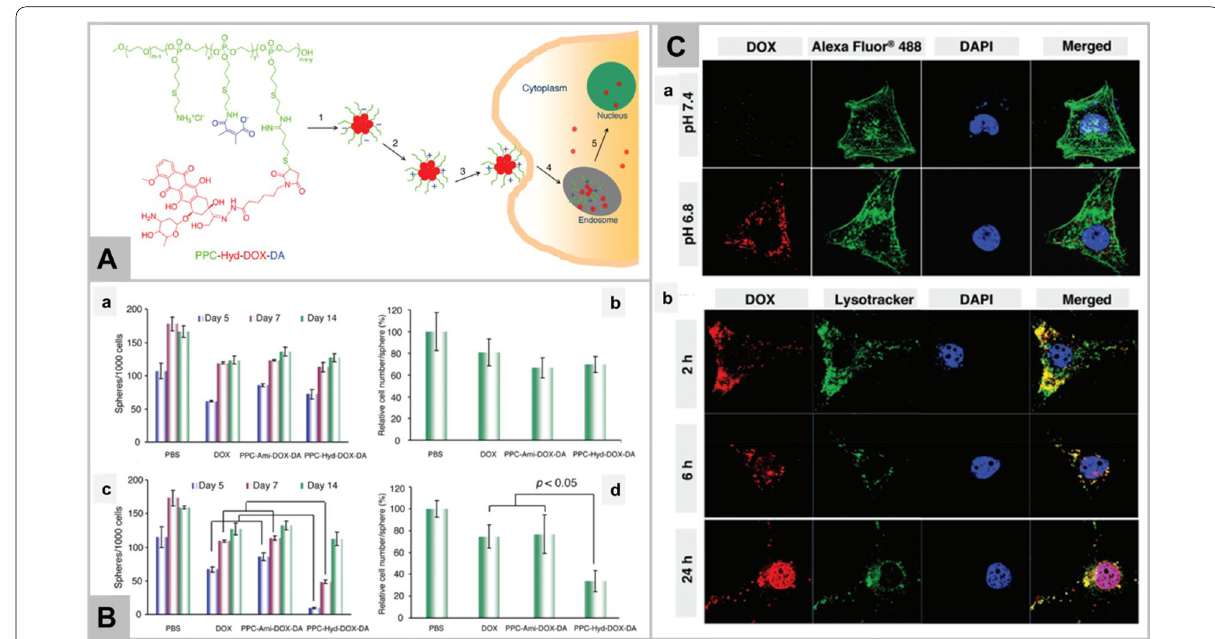
Fig. 8 Chemical Structure of the Dual pH-Responsive Polymer. Doxorubicin (DOX) Conjugate (PPC-Hyd-DOX-DA) and Schematic Illustration of Its pH Triggered Cellular Internalization and Intracellular Drug Release (Panel A ). Time-dependent sphere formation of SK-3rd cells after incubation with various formulations ( a and c ) and the relative cell numbers/sphere measured at 14 days ( b and d ). Cells were first incubated with the formulations in culture media for 2 h at pH 7.4 ( a and b ) or 6.8 ( c and d ), and then the media were replaced with fresh media and further incubated at pH 7.4. p < 0.005. PBS control was set as 100%. The dose of DOX or its equivalent was 2 μg/mL (Panel B ). ( a ) Cellular uptake of PPC-Hyd-DOX-DA NPs (red) at pH 6.8 or 7.4 after incubation with MDA-MB-231 cells for 1 h. DAPI (40, 6-diamidino-2 phenylindole, blue) and Alexa Fluor488 phalloidin (green) were used to stain cell nuclei and F-actin, respectively. ( b ) Subcellular distribution of PPC-Hyd-DOX-DA NPs (red) at pH 6.8. DAPI (blue) and Lysotracker Green (green) were used to stain the cell nuclei and acidic organelles. Cells were imaged using a 60 water-immersion objective (Panel C ). Reprinted with permission from Journal of American Chemical Society, Copyright 2011, American Chemical Society